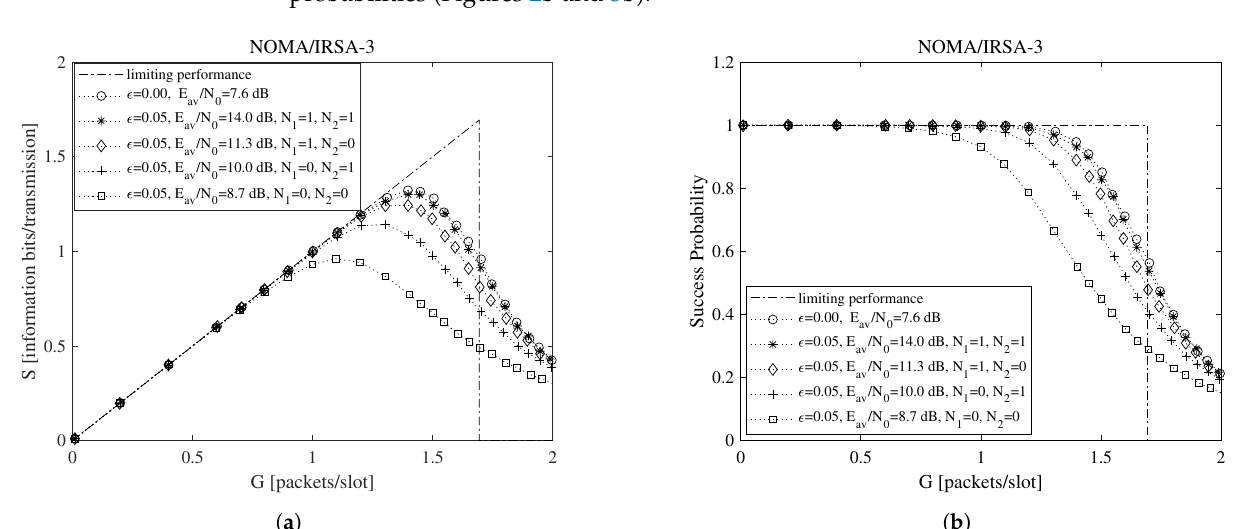
Figure 2. Performance as a function of the channel load for NOMA/IRSA-3 with K = 100, L = 3, and R = 1 information bits per symbol: ( a ) throughput, ( b ) success probability.